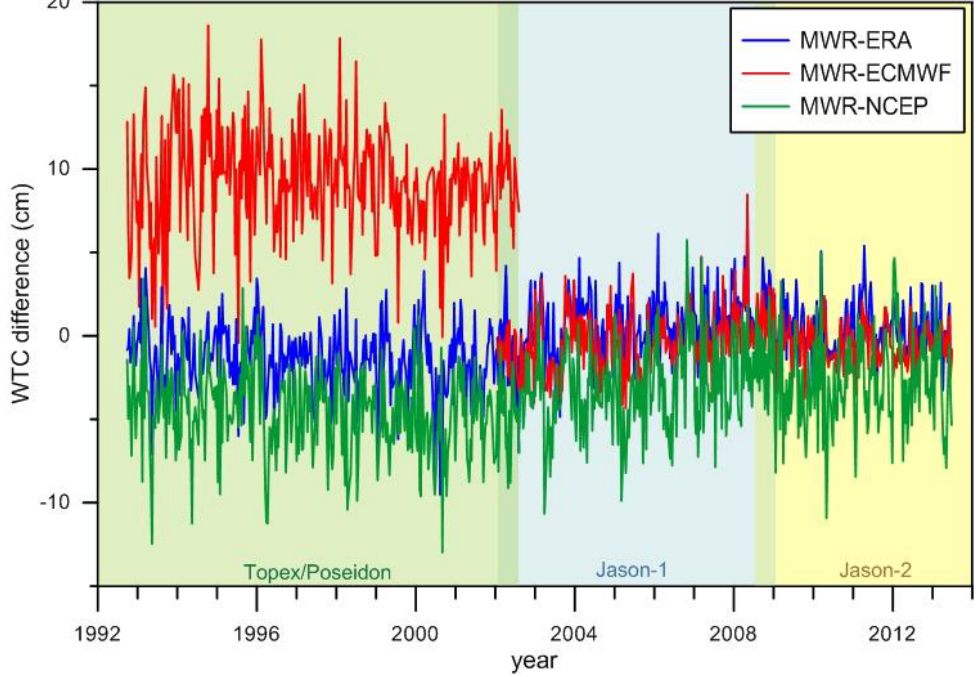
Figure 11. Mean cycle differences between the MWR-derived WTC and the corresponding values from three models, over Lake Victoria, for T/P Phase A, Jason-1 Phase A and Jason-2. Only measurements over inland water with valid MWR correction were considered.